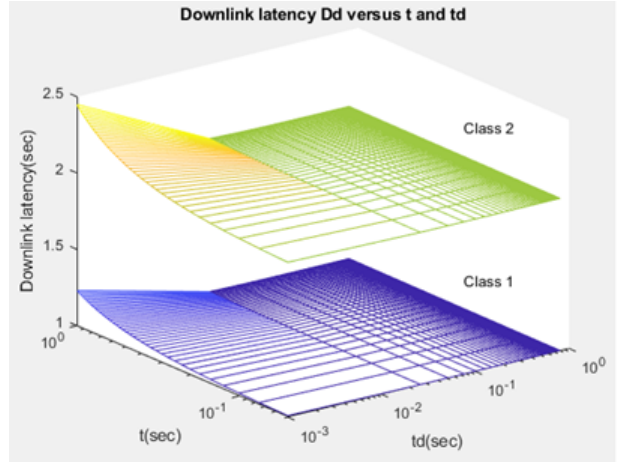
Figure 16. Latency of downlink service request— D dj